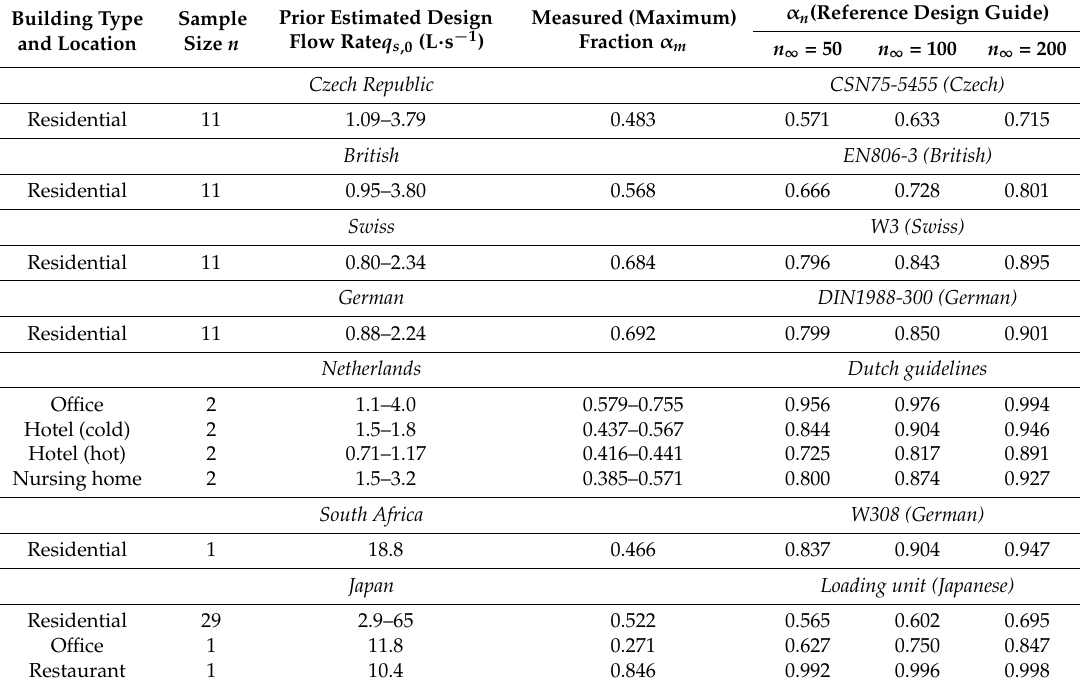
Table 4. Bayesian coefficients of design flow rates α n